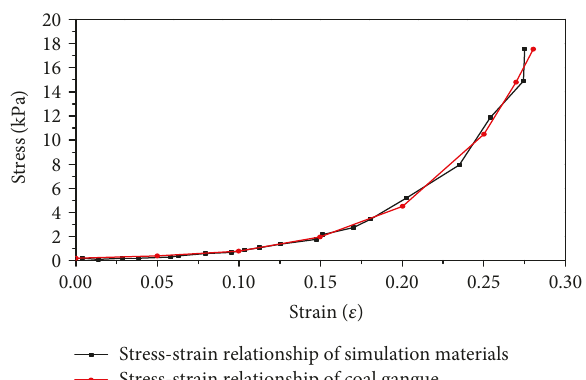
Figure 5: Contrast of stress-strain relationship between coal gangue and simulation